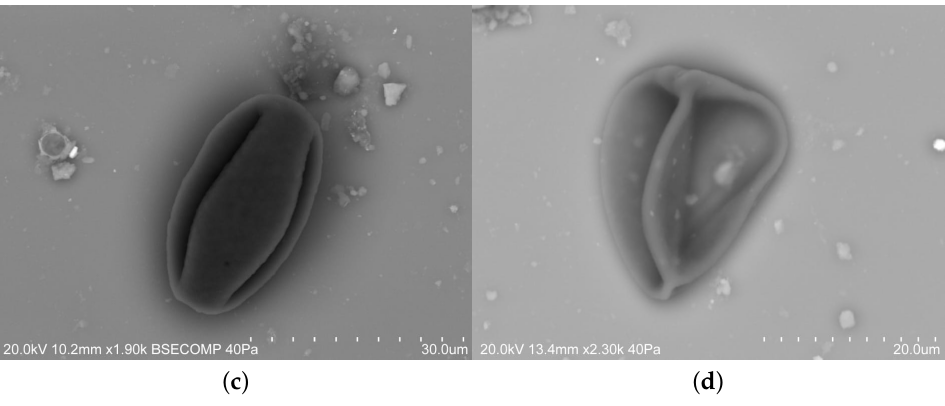
Figure 7. Pollen species from glass sample SEM: ( a ) Arecaceae ; ( b ) Pinaceae ; ( c ) Quercus sp ; ( d ) Poaceae